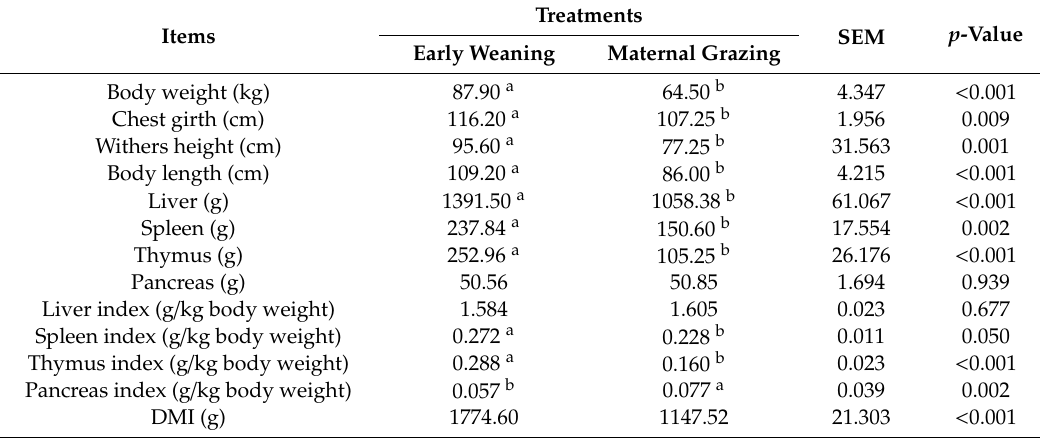
Table 1. E ff ect of early-weaning feeding and maternal grazing feeding on body weight, body size indexes, and organ weight of yak